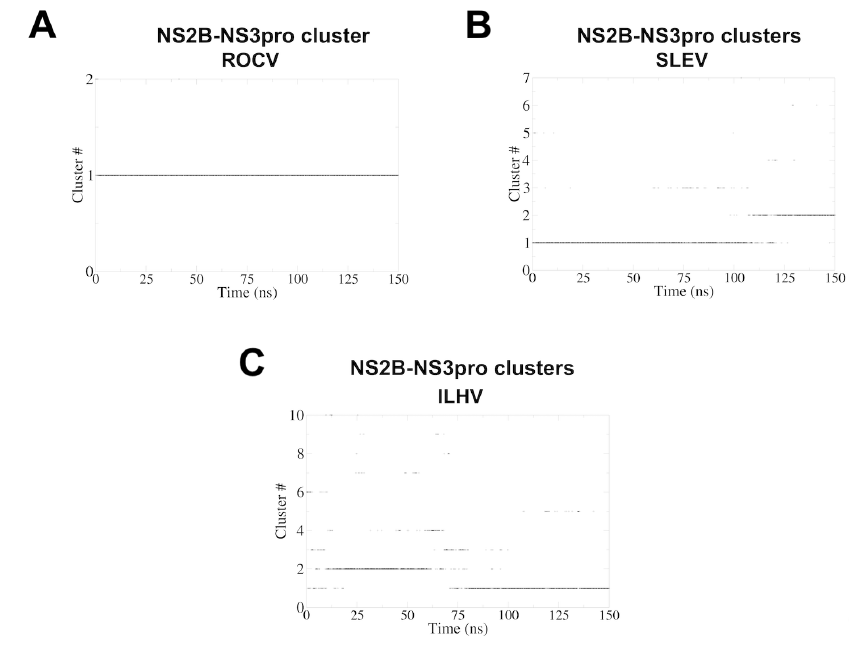
Figure 1. Cluster analysis with 0.25 nm cutoff. ( A ) Rocio virus, ( B ) Saint Louis encephalitis, ( C ) Ilhéus